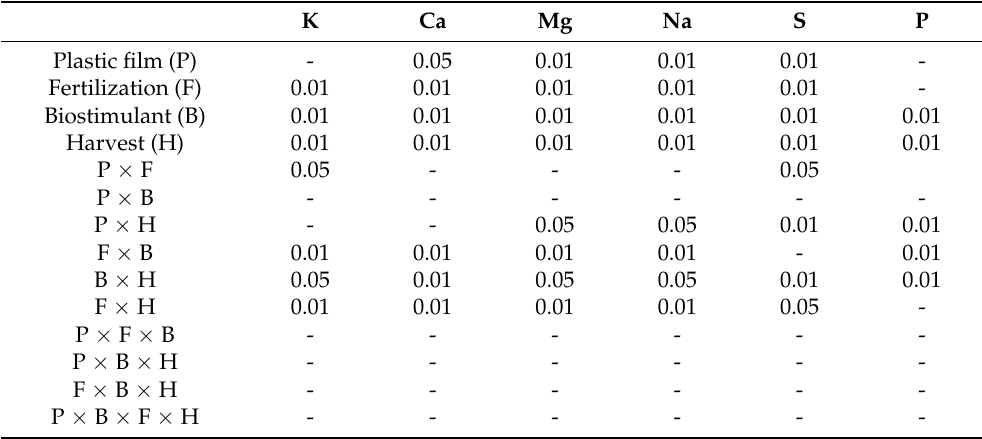
Table 2. Analysis of variance on mineral content of rocket as affected by the different experimental factors: significance of main factors and interactions.